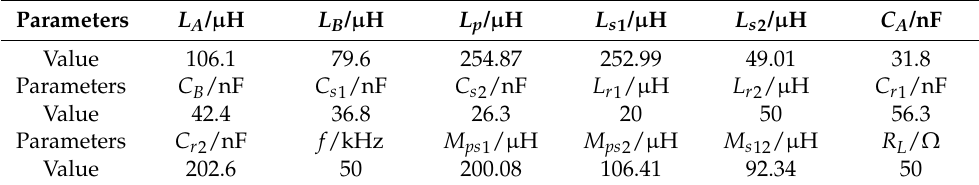
Table 2. Parameters of the dual-channel system.